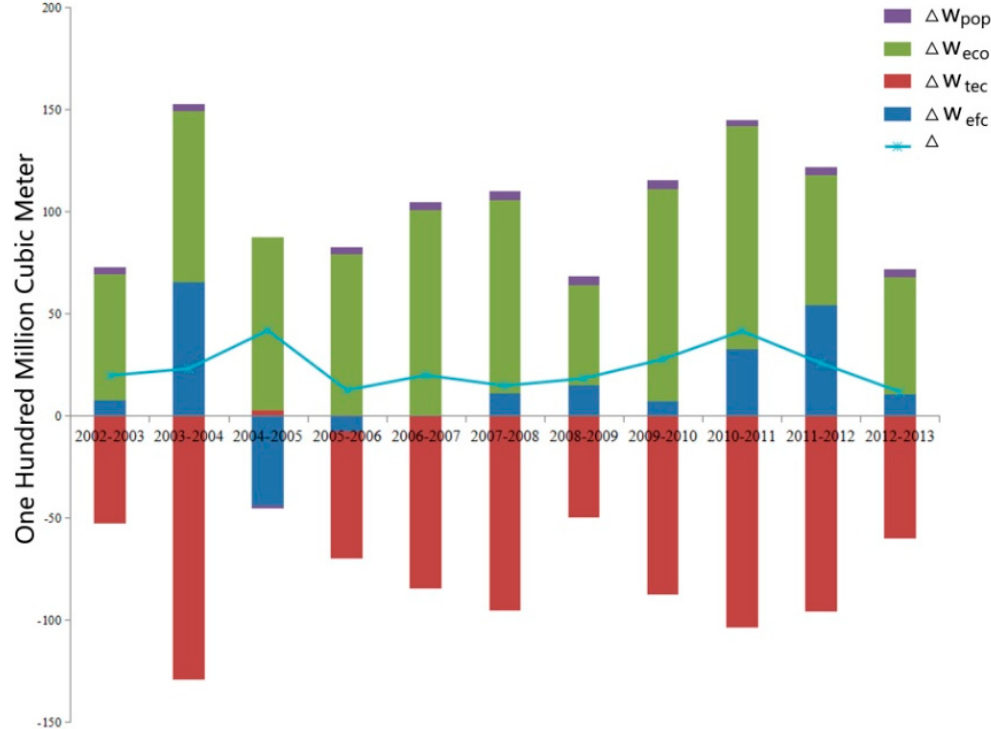
Figure 5. Decomposition analysis results of wastewater discharge in China, 2002–2013.